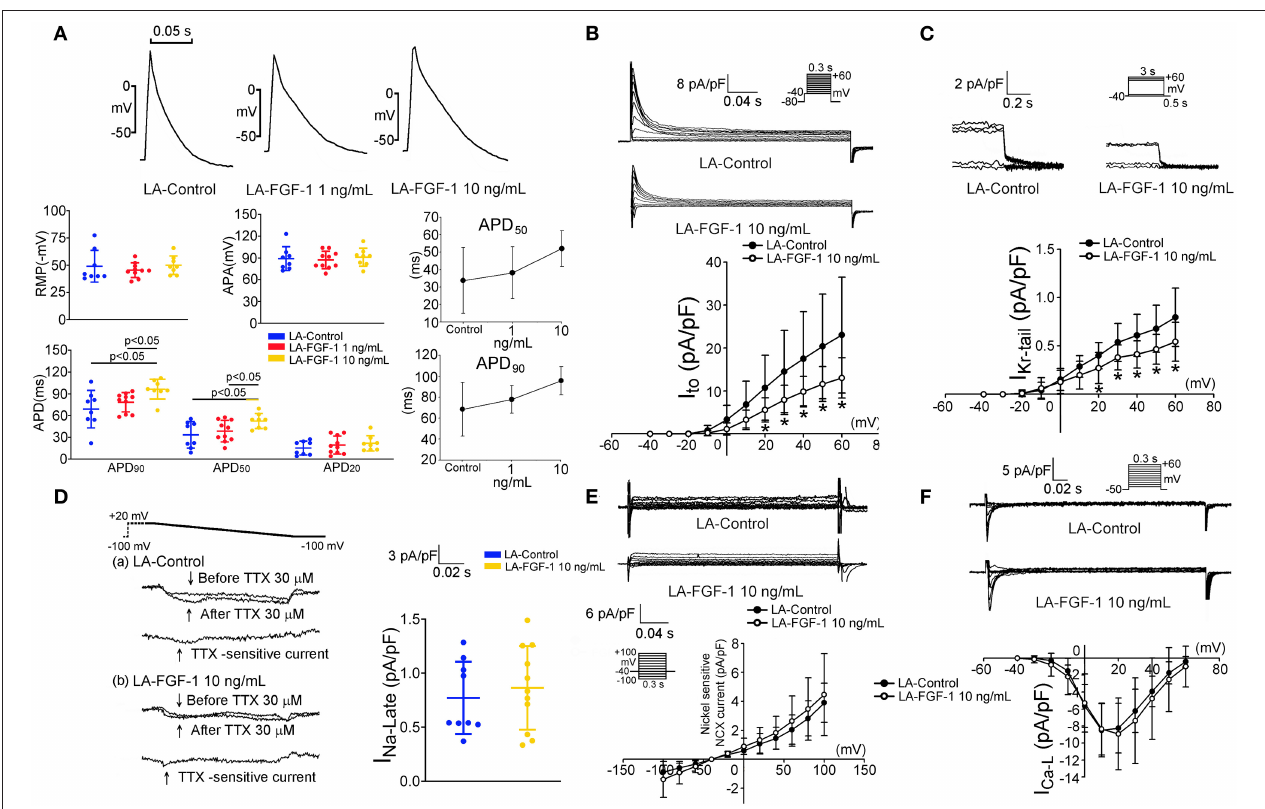
FIGURE 4 | Effect of fibroblast growth factor 1 (FGF1) on action potential morphology, transient outward potassium current ( I to ) and rapid delayed rectifier potassium current (